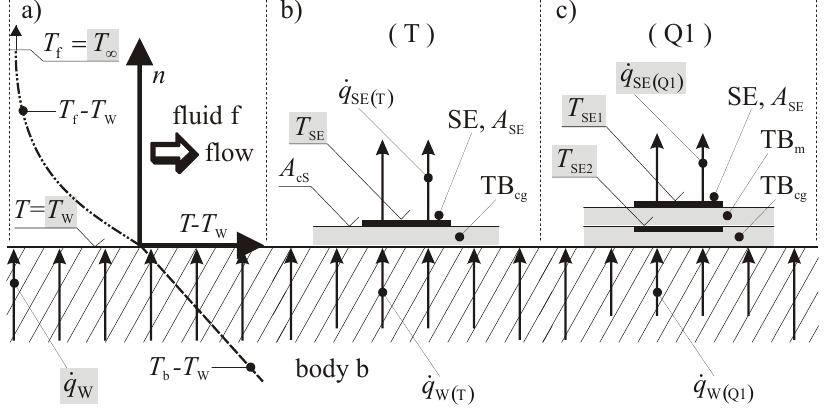
Figure 10. Undisturbed convective heat transfer situation and measureable values using glue-on-type sensors. a) Temperature distribution in a steady convective heat transfer according to Figure 2. b) Wall-temperature sensor glued on the surface. c) Heat-flux sensor glued on the surface.